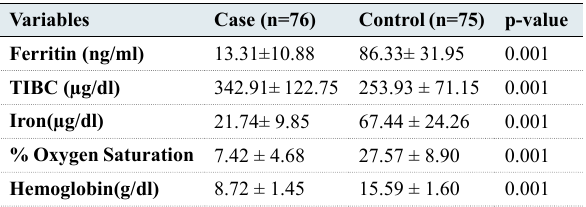
Table 1: Comparison of hematological and iron